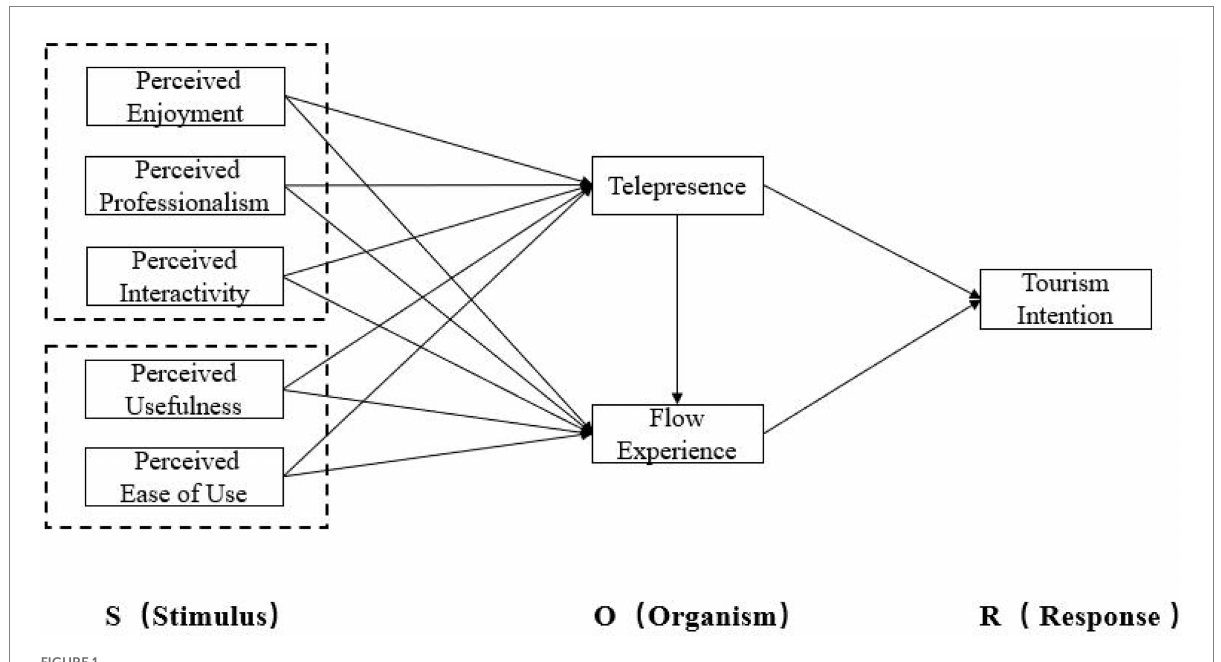
FIGURE 1 Research model of users’ tourism